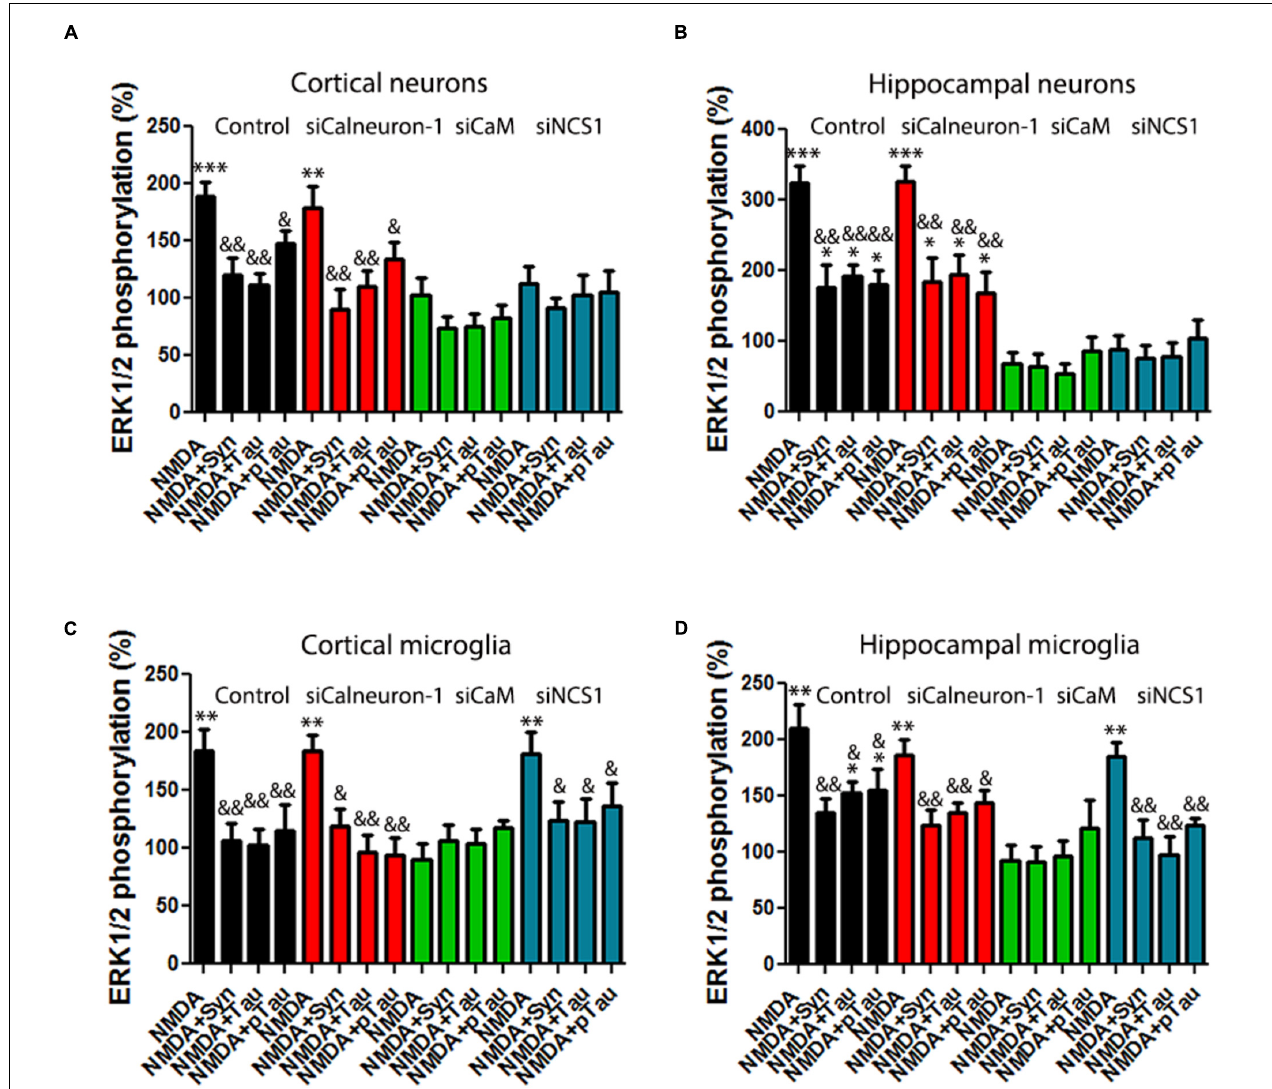
FIGURE 4 | Acute treatment with Tau, p-Tau, or α -synuclein inhibits NMDAR-mediated signaling in primary cultures. (A–D) MAPK phosphorylation levels were analyzed after stimulating primary cultures of cortical (A) , or hippocampal neurons (B) , or of cortical (C) , or hippocampal microglia (D) . Labels in X axis are equal in all bar graphs. Experiments were performed in cells transfected or not (black bars) with siRNA to silence calneuron-1 (red bars), CaM (green bars), or NCS1 (blue bars) expression. Assays were performed in cells treated with α -synuclein, Tau, or p-Tau for 2 h prior to 15 µ M NMDA addition. Values are the mean ± SEM ( n = 10). Significant differences over non-treated cells ( ∗∗ p < 0.01 and ∗∗∗ p < 0.005) or over NMDA treatment ( & p < 0.05 and && p < 0.01) were calculated by one-way ANOVA and Bonferroni post hoc